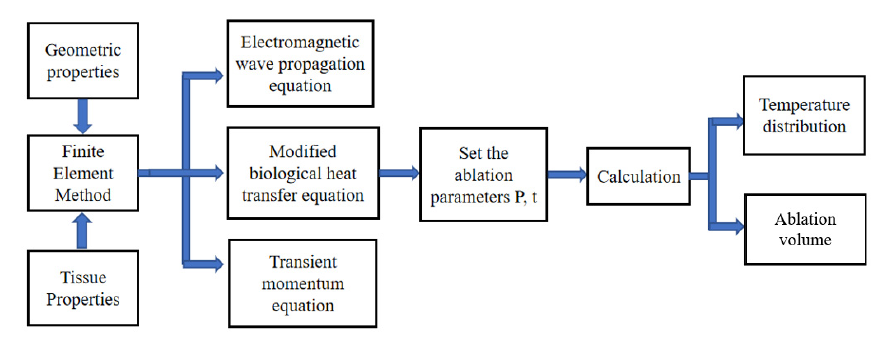
Figure 2. The scheme of the numerical simulation.